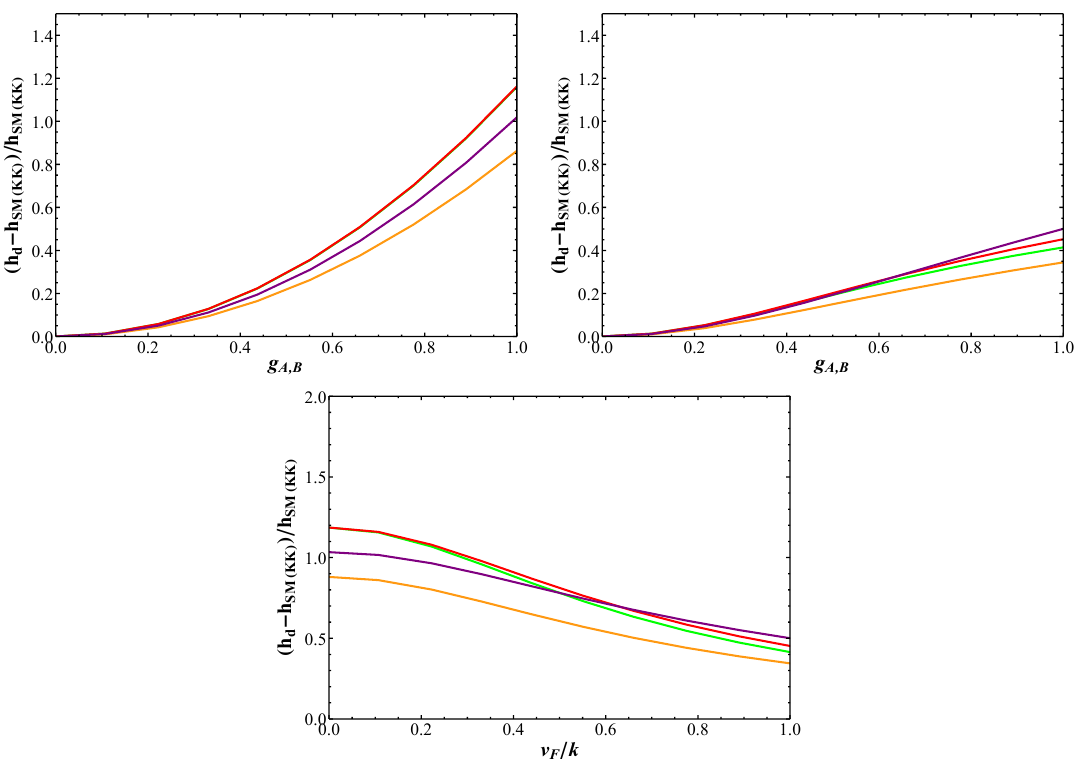
Figure 12. The dependence of the parameter h d on g A;B for v F = 0 : 1 k (top left), on g A;B for v F = k (top right), and on v F for g A;B = 1 : 0 (bottom), for di(cid:11)erent points in our sample parameter space, as represented by curves of di(cid:11)erent